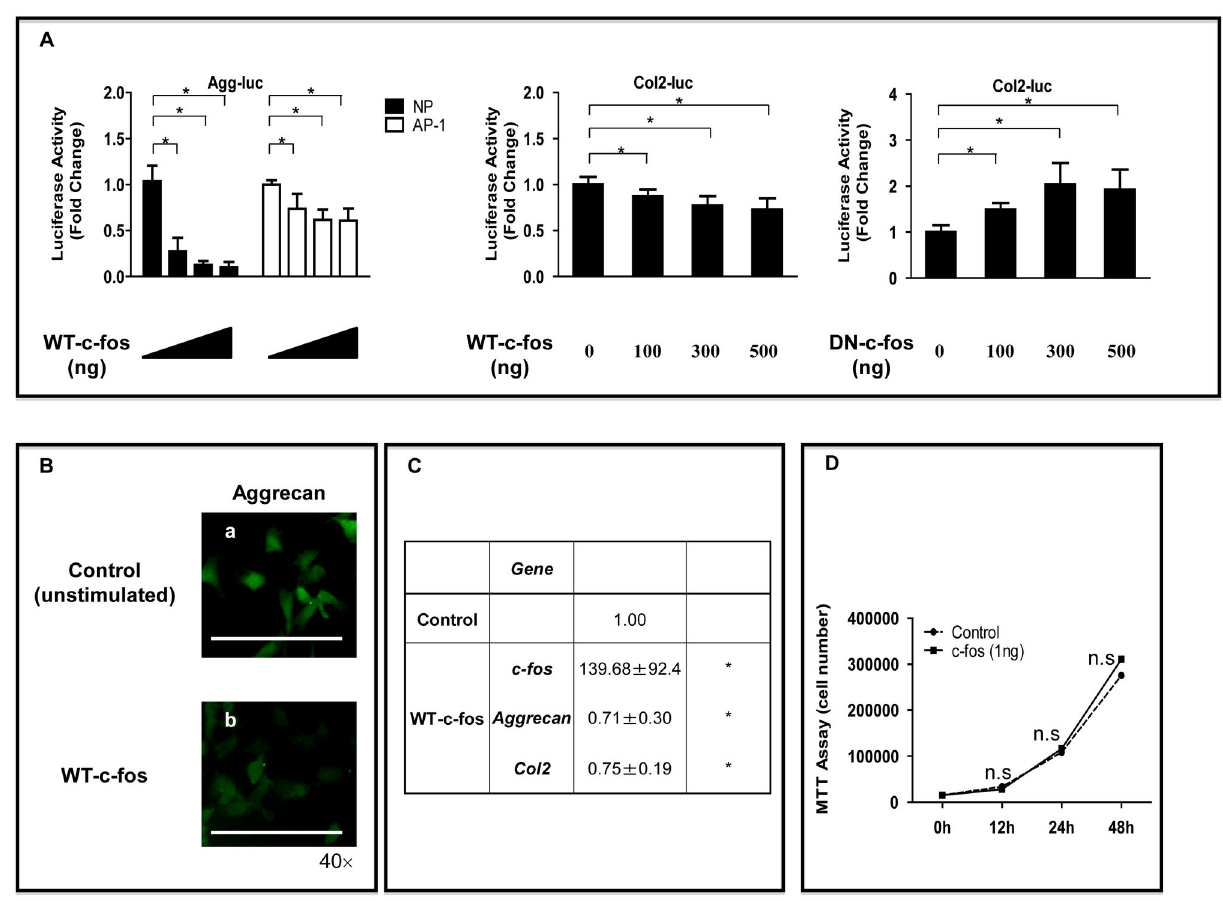
Figure 6. Effect of c-fos on aggrecan (Agg) and collagen type II (Col2) expression and cell proliferation in NP cells. ( A ) NP cells or stable AP-1 reporter cell were cotransfected with the Agg (400 ng) or Col2 (400 ng) reporter constructs and increasing concentrations of the WT-c-fos plasmid (100–500 ng), the DN-c-fos (100–500 ng) plasmid, or empty backbone. * P < 0.05 indicates differences between groups. Error bars represent the SD. ( B ) Detection of Agg protein expression by immunofluorescence microscopy. NP cells were cultured with ( a ) or without ( b ) WT-c-fos for 24 h, fixed, and stained with an antibody against Agg (green). Scale bar= 100 μm(C) Real-time-RT-PCR analysis of c-fos, Agg or Col2 expression in cells treated with vehicle (control) or a WT-c-fos expression plasmid. Total RNA was extracted from transfected cells and real-time RT-PCR was used to determine c-fos, Agg, Col2 and GAPDH RNA levels as an internal control. ( D ) The NP cells were treated with c-fos (1 ng/mL) in 96-well plates. Cell proliferation was evaluated using the MTT viability assay 12 or 24 h after treatment. n.s. = not significant. doi: